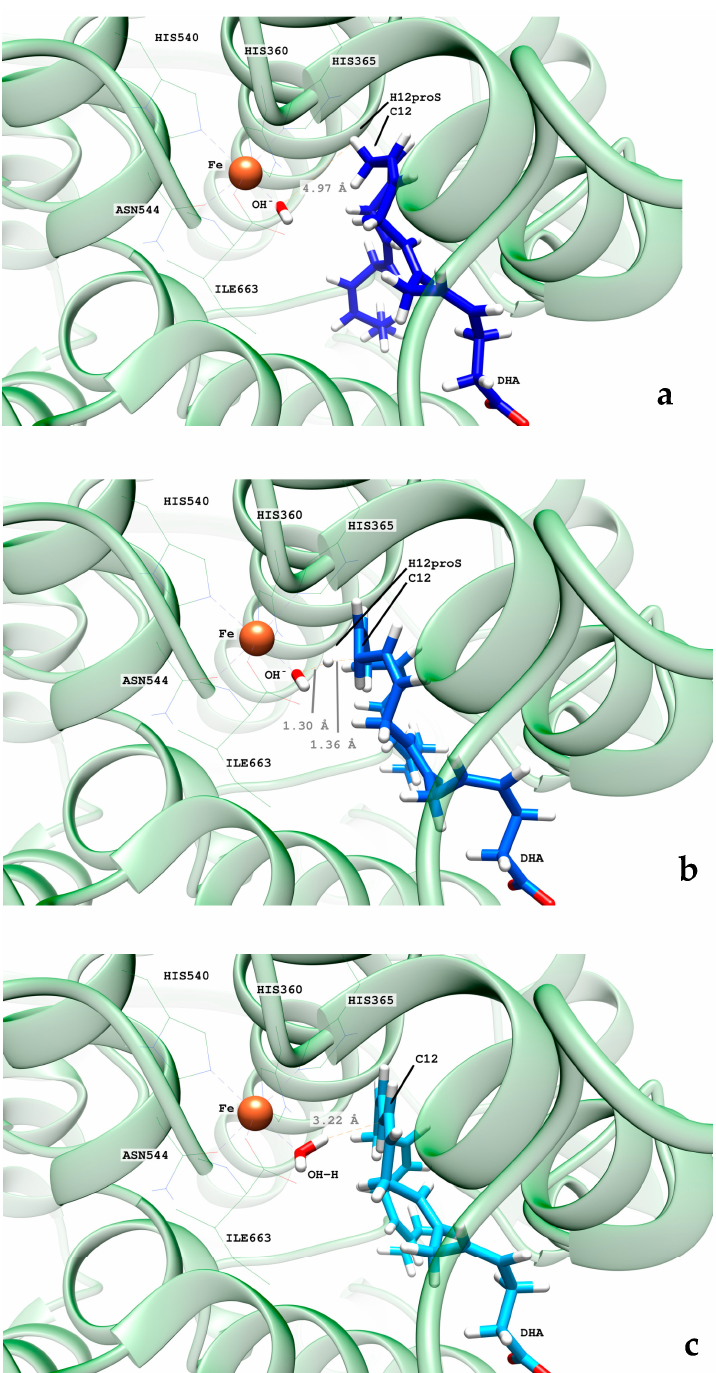
Figure 12. Images of the optimized reactant ( a ), transition state structure ( b ), and product ( c ) of the H 12proS abstraction initiated from snapshot 8721 in hALOX12. The distance between H 12proS and the oxygen atom in OH − is shown for the optimized reactant ( a ). At the transition state structure, the distances between the shifting hydrogen with respect to C 12 (donor atom) and the oxygen atom in OH − (acceptor atom) are depicted ( b ). The distance between the H atom in the nascent water mole- cule and C 12 is plo tt ed at the optimized product ( c ).